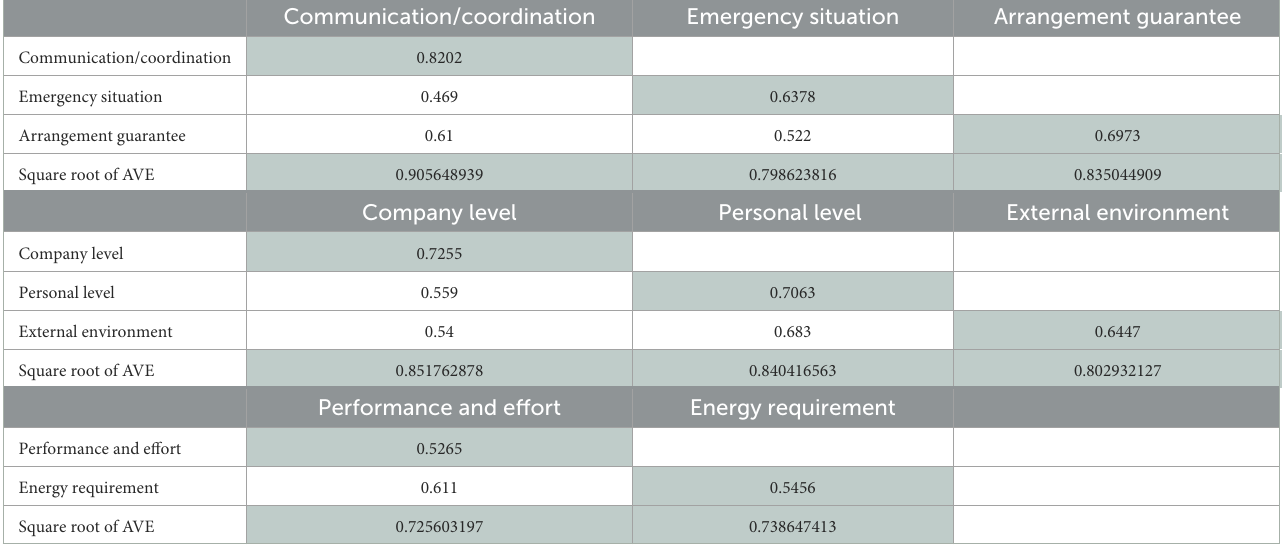
TABLE 6 Statistics of the correlation coefficients between the latent variables of fatigue factors in terms of the “work” dimension of long-haul flight pilots.